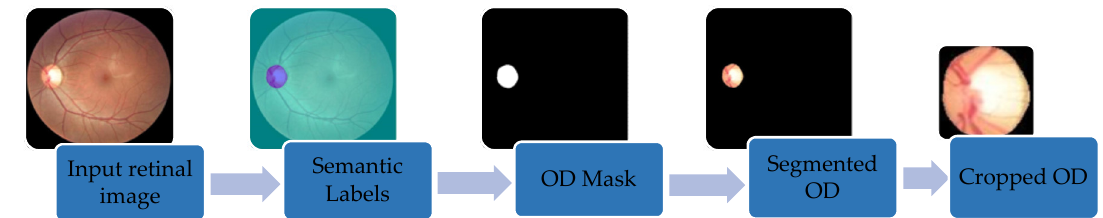
Figure 4. Retrieving OD regions from the full retinal image using DeepLabv3+ and cropping to the bounding box.